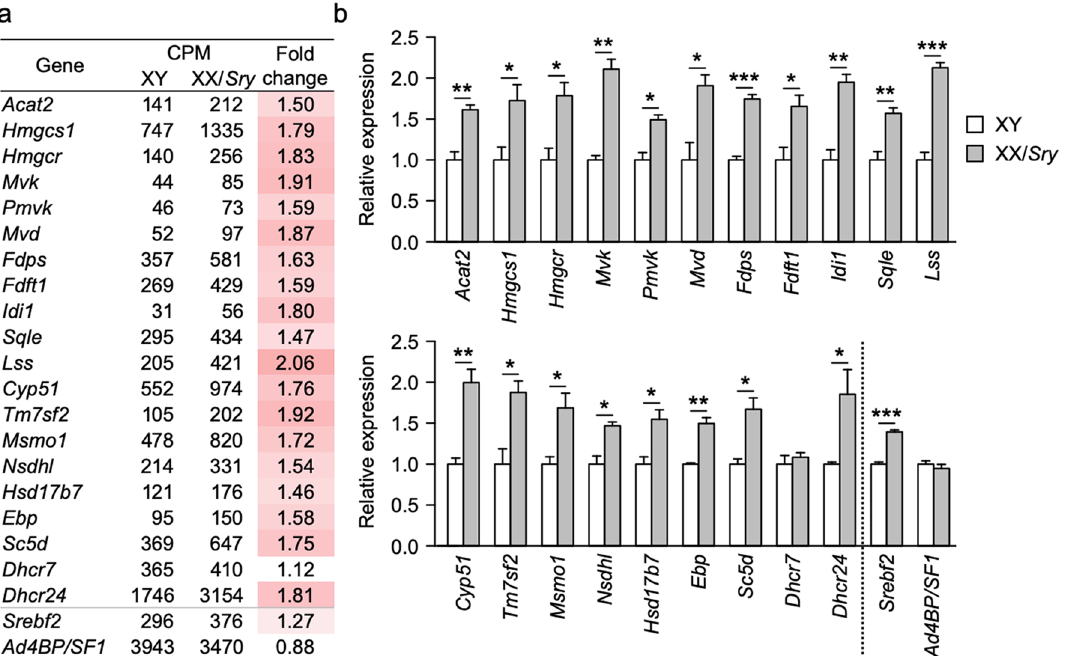
Figure 3. Cholesterogenic gene expression increased in XX/ Sry ALCs. ( a ) Expression of cholesterogenic genes as well as Srebf2 and Ad4BP/SF-1 was extracted from the transcriptome datasets for the XY and XX/ Sry ALCs. CPMs are means of biological triplicates. Cells in the fold change column are shaded according to difference in expression: the greater the increase, the deeper the red shading. ( b ) Expression of the cholesterogenic genes, Srebf2 , and Ad4BP/SF-1 was validated using qRT-PCR. The data were normalized to Actb and are presented as means ± SEM. Three biologically independent samples (n = 3) were used. * p < 0.05, ** p < 0.01, *** p < 0.001, using Student’s t -test ( b ). R software version 3.4.3 (https ://www.r-proje ct.org) was used to draw the plots in ( b